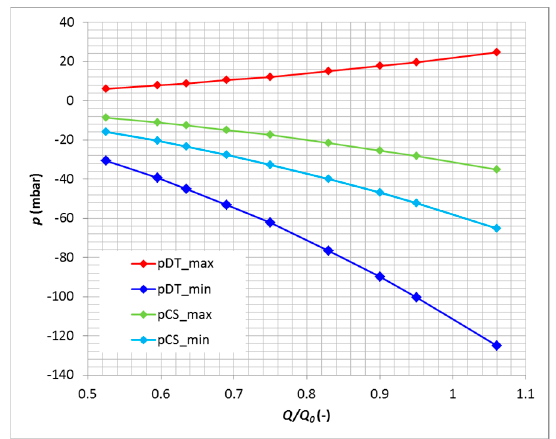
Figure 4. Minimum and maximum pressure simulated values in function of relative discharge in the draft tube (pDT_min, pDT_max) and cone section (pCS_min,